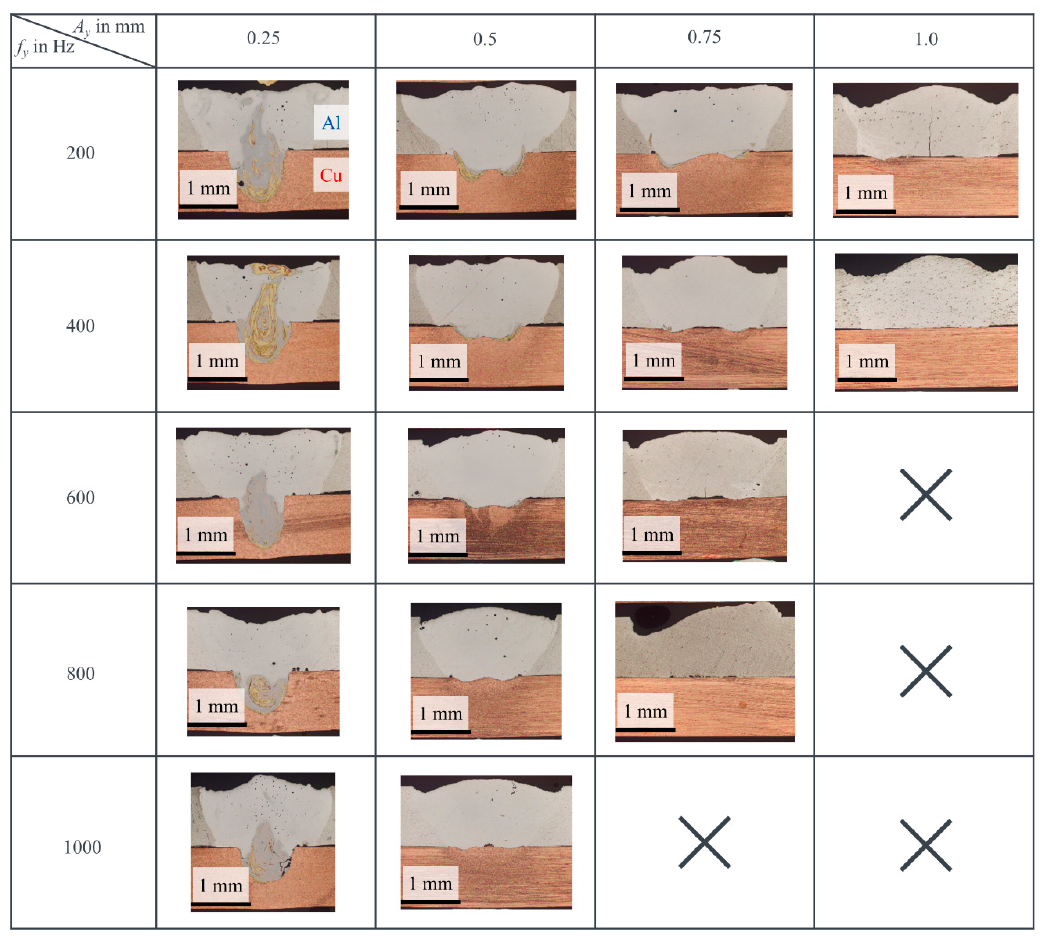
Figure 8. Micrographs of cross-sections from welds produced with spatial oscillation of the laser beam with 3.25 kW of laser power and a feed rate of 6 m/min.